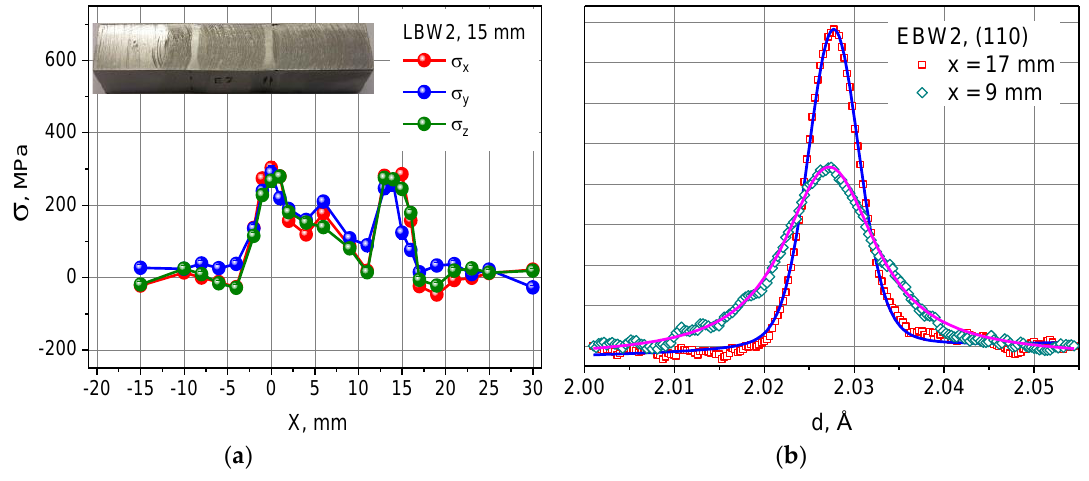
Figure 16. (a) Residual stress distribution in the test Charpy specimen (LBW2) reconstituted by the laser beam welding technique. Inset: LBW2 Charpy specimen (10 × 10 × 55 mm 3 ) with two weld seams at X = 0 and X = 14 mm, adapted from [38], with permission from © 2016 Springer. ( b ) Diffraction peak (110) profile fitted with a Voigt function at the weld seam center ( X = 9 mm) and in the base material ( X = 17 mm).